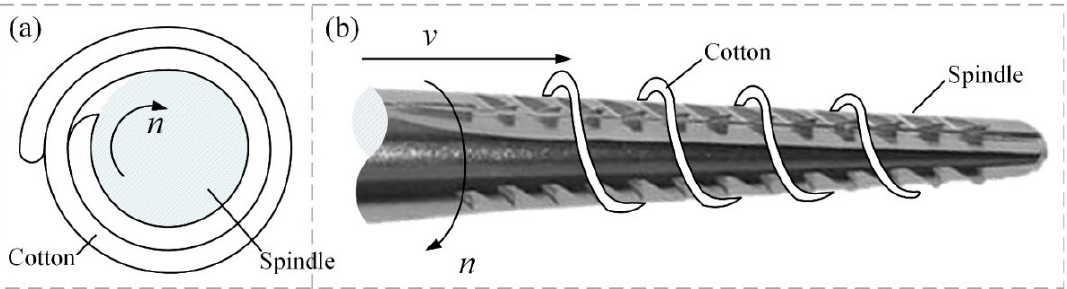
Figure 5. Spindle winding cotton method: ( a ) overlapping winding and ( b ) spiral winding.Figure 4b shows that the picking time gradually decreases with the increase of spindle speed. This is because the length of the cotton after elongation is limited under a certain elongation rate of the cotton flap, and the higher the spindle speed, the shorter the winding time. With the increase of the feed speed, the picking time gradually decreased. This is because the variation range is small due to the winding of the cotton being spiral overlapping when the feeding speed of the spindle is low. Additionally, the cotton wound on the surface of the spindle is mainly concentrated at the front end of the spindle because the diameter of the front end of the spindle is small, and the winding time is longer for a certain length of cotton. When the feed speed is high, the winding method of the spindle is spiral winding, the surface of the spindle is evenly wound with cotton, and the winding time is short for a certain cotton length [35].